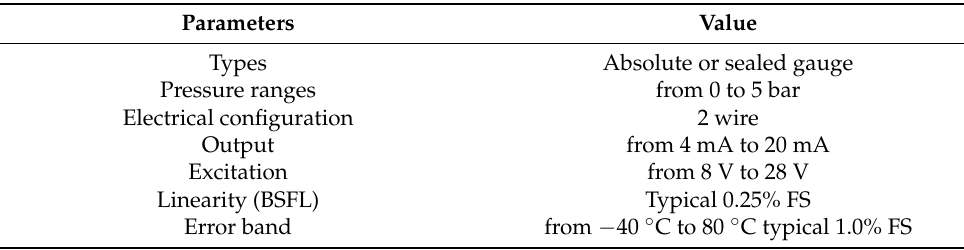
Table 3. Parameters of the Keller 21G pressure sensor (Adapted from [31]). Reproduced from [31],